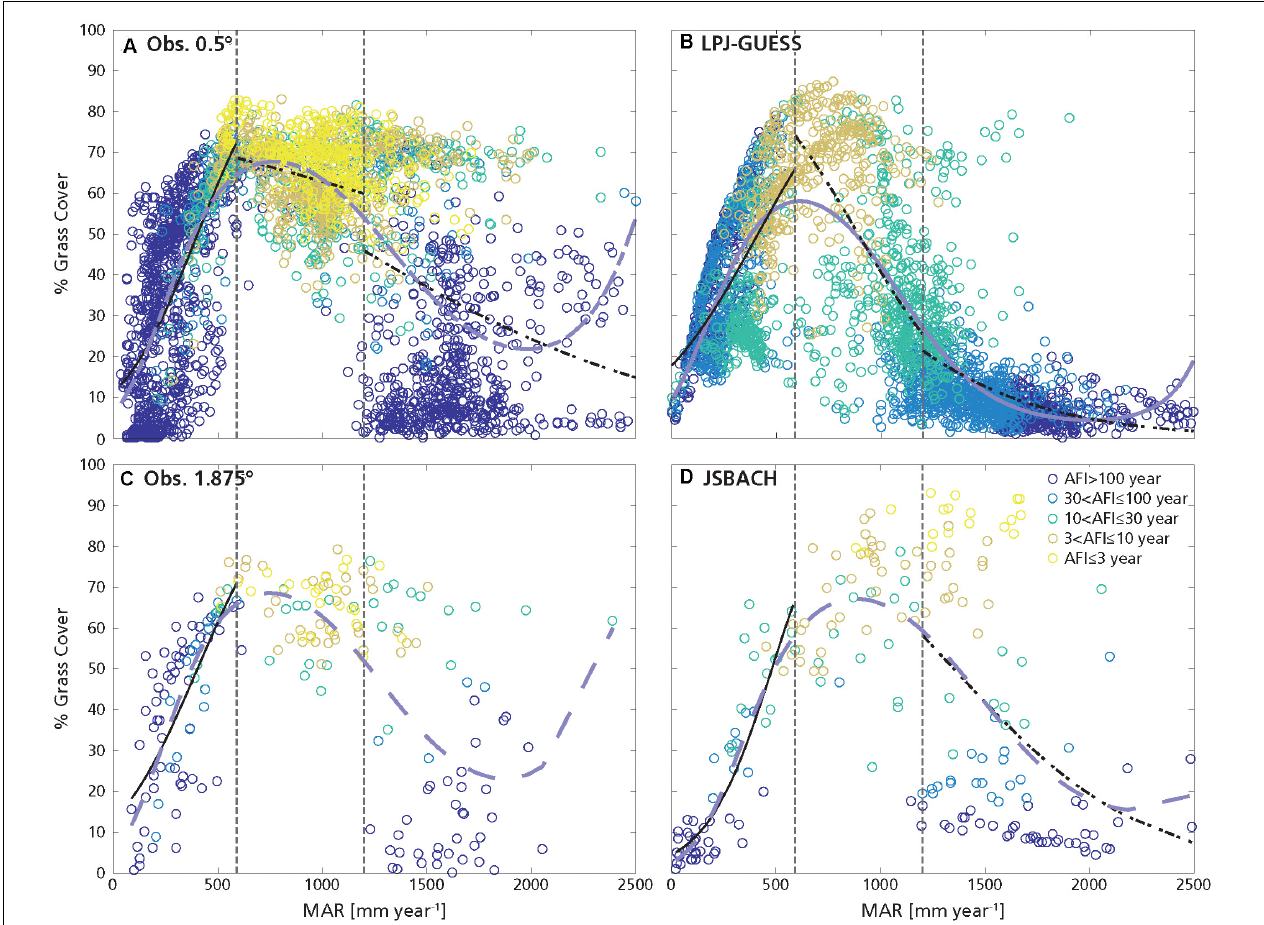
FIGURE 3 | Same as Figure 1 but for grass cover. The colors of the circles indicate the average fire intervals (AFI, see legend for values). Panels: (A) obs. 0.5 ◦ , (B) LPJ-GUESS, (C) obs. 1.875 ◦ , and (D)